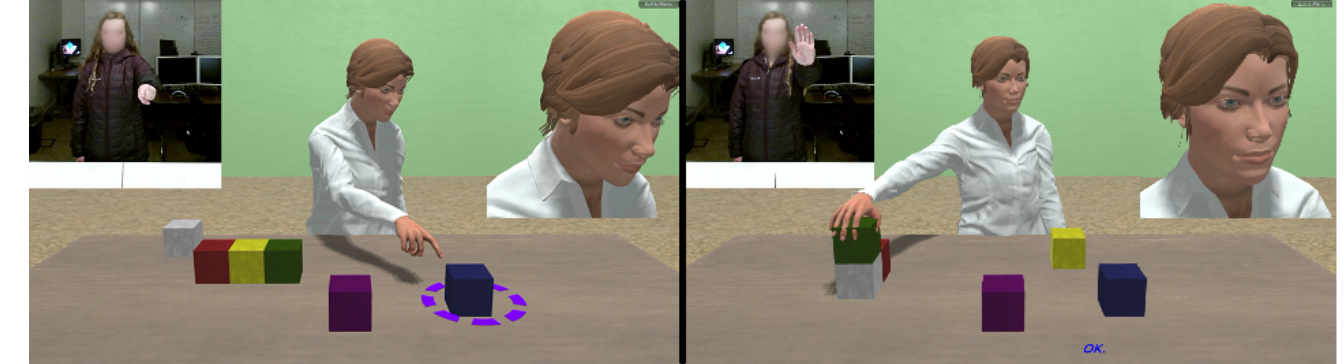
Figure 3. Pointing and never-mind, the two most frequently used gestures during user